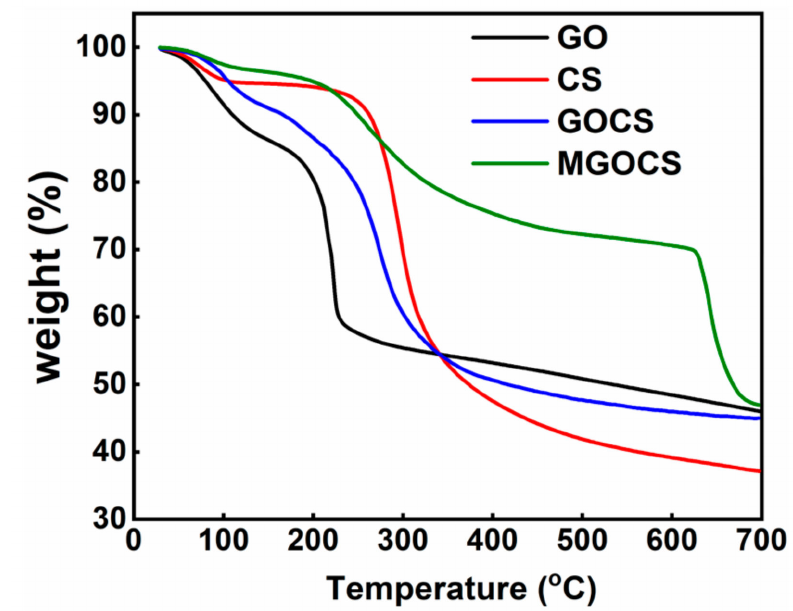
Figure 4. TG analysis of GO, CS, GOCS, and